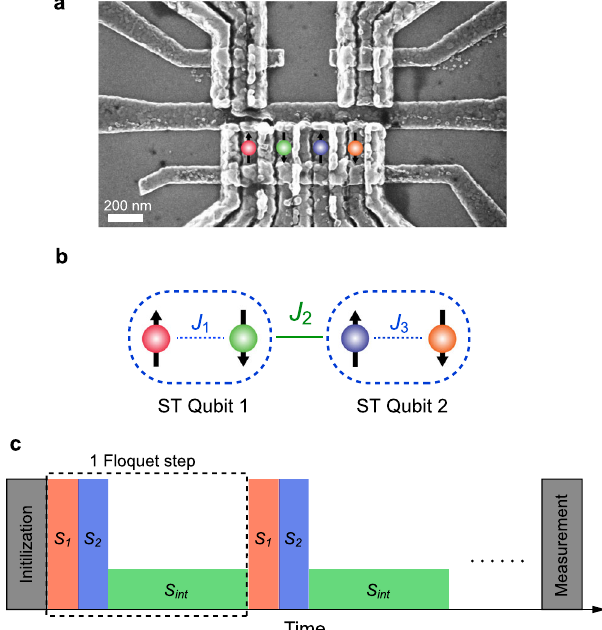
Fig. 1 Experimental setup. a Scanning electron micrograph of the quadruple quantum dot device. The locations of the electron spins are overlaid. b Schematic showing the two-qubit Ising system in a four-spin Heisenberg chain. c The pulse sequence used in the